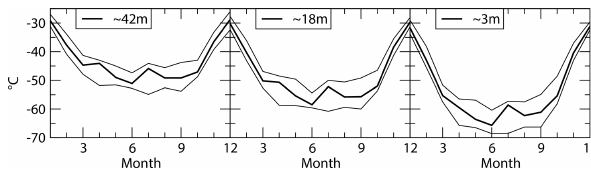
Figure 7. Seasonal cycle of temperature averaged over 3 years (2018–2020) at the three levels with paired, modified thermohy- grometers (bold line). The thin lines show the envelope of the ± 2 standard deviation of the interannual variability from the 10-year (2010–2019) seasonal cycle published in Genthon et al.